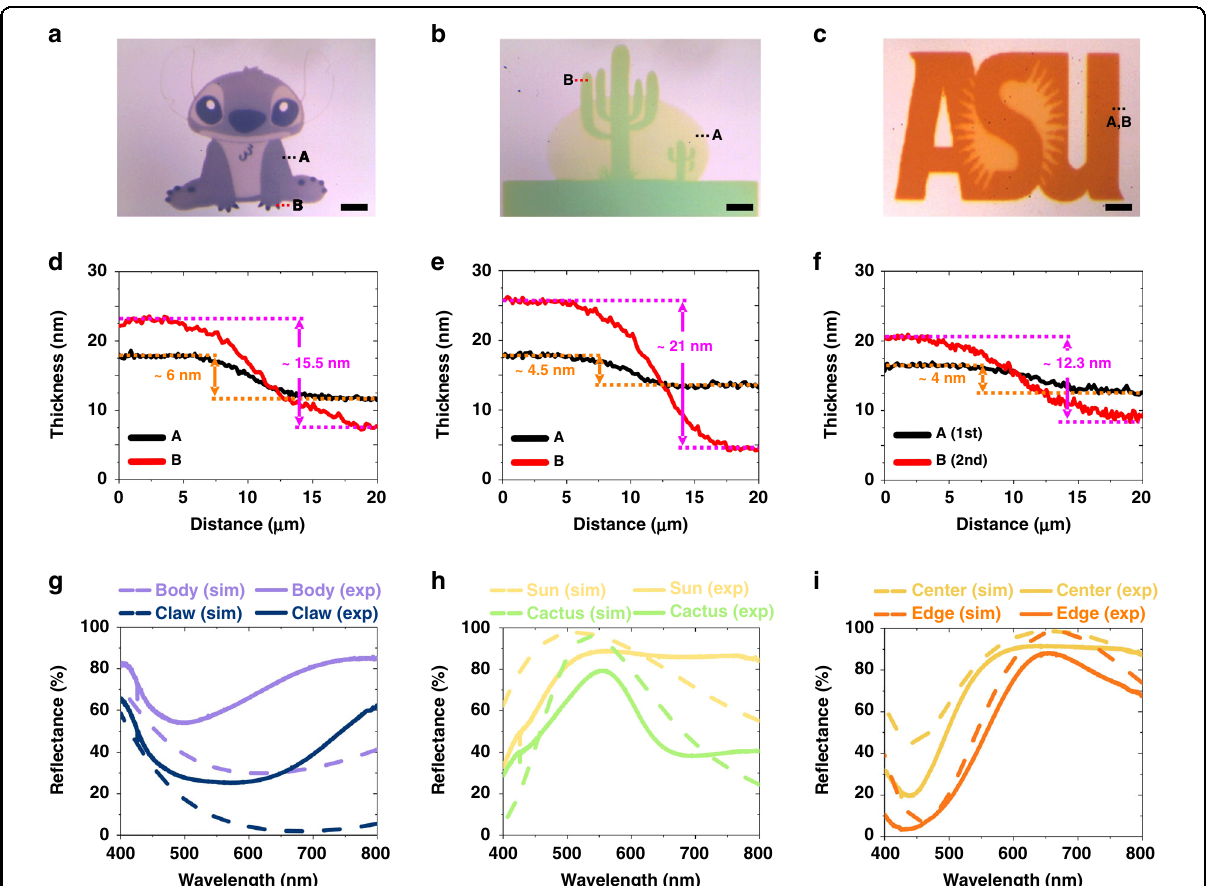
Fig. 5 Demonstration of the feasibility of printing complex structures with various colors. a A cartoon character “ Stitch ” ( d = 75 nm), b a symbol of Arizona “ Cactus ” ( d = 150 nm), and c a logo of “ ASU ” ( d = 200 nm). Scale bar: 100 μ m. d – f AFM measured PPD fi lm thicknesses t for each structure corresponding to ( a – c ), respectively. g – i FDTD simulated re fl ectance spectra (dashed lines) and experimentally measured re fl ectance spectra (solid lines) for each structure corresponding to ( a – c ),